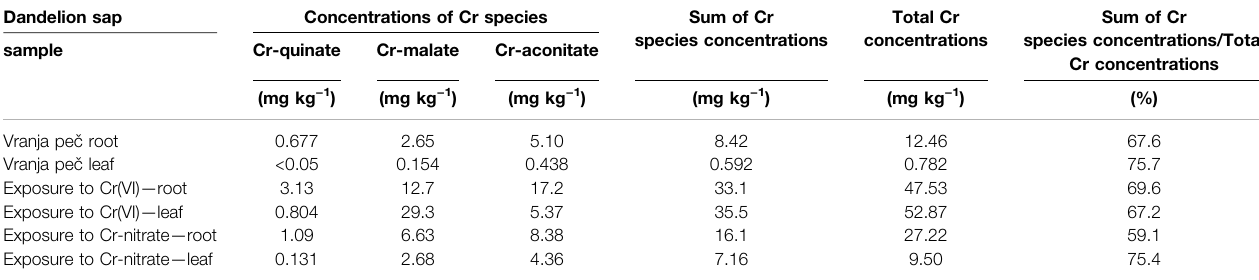
TABLE2| ConcentrationsofCrspecies,sumofCrspeciesconcentrationsandtotalCrconcentrationsindandelionrootanddandelionleafsapfromdandelionsgrowninsoil fromVranjape č withahighCrcontent581 mg kg − 1 anddandeliongrowninsoilwithalowCrcontent55.9 mg kg − 1 ,exposedfor48 htosyntheticsolutionsofCr(VI)and